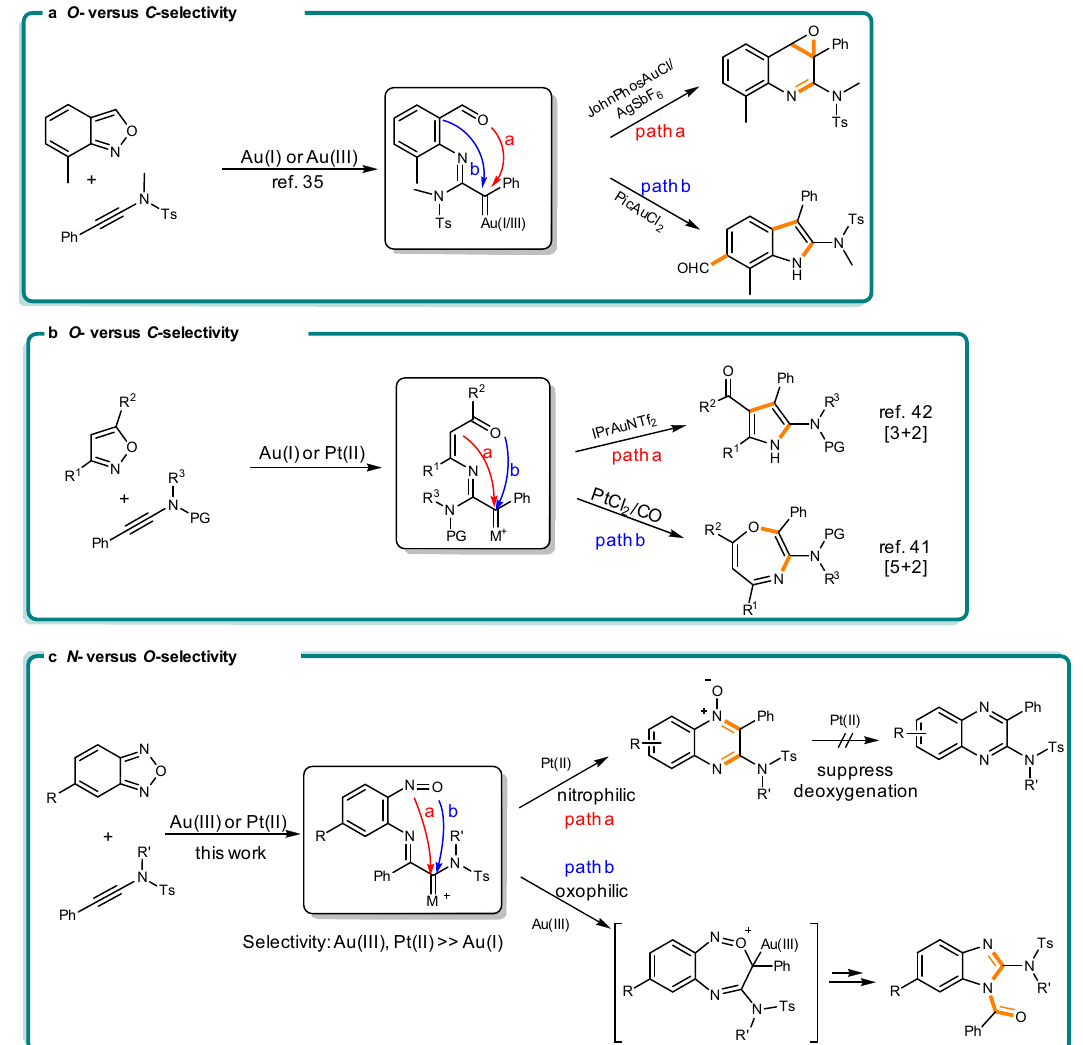
Fig. 1 Tunable gold and platinum carbene annulations. a Selectivity of gold(I) and gold(III) carbene. b Selectivity of platinum(II) and gold(I) carbene. c This work: Selectivity of platinum(II) and gold(III)